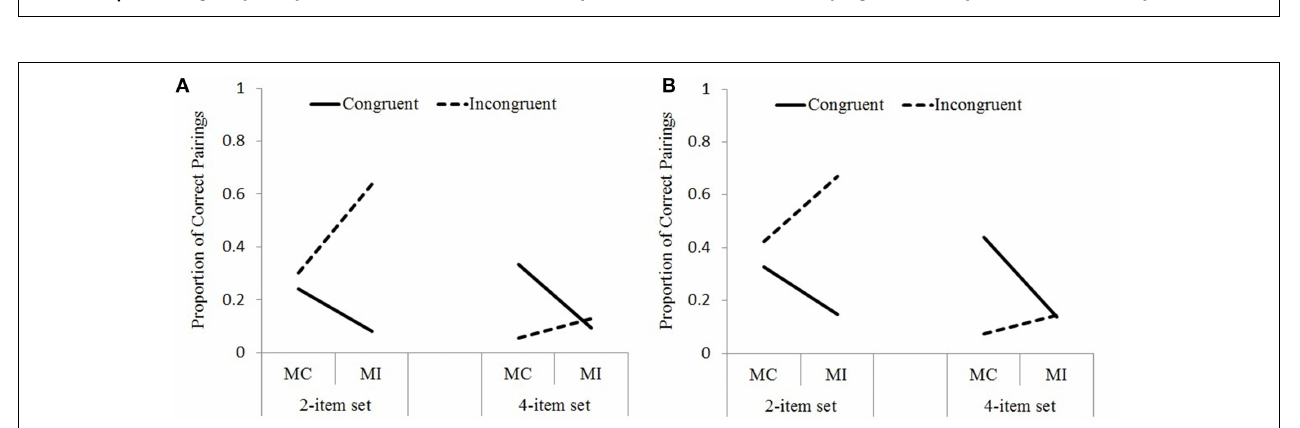
FIGURE 8 | Proportion of correct pairings for the matching question in Experiment 1 (A) and Experiment 2